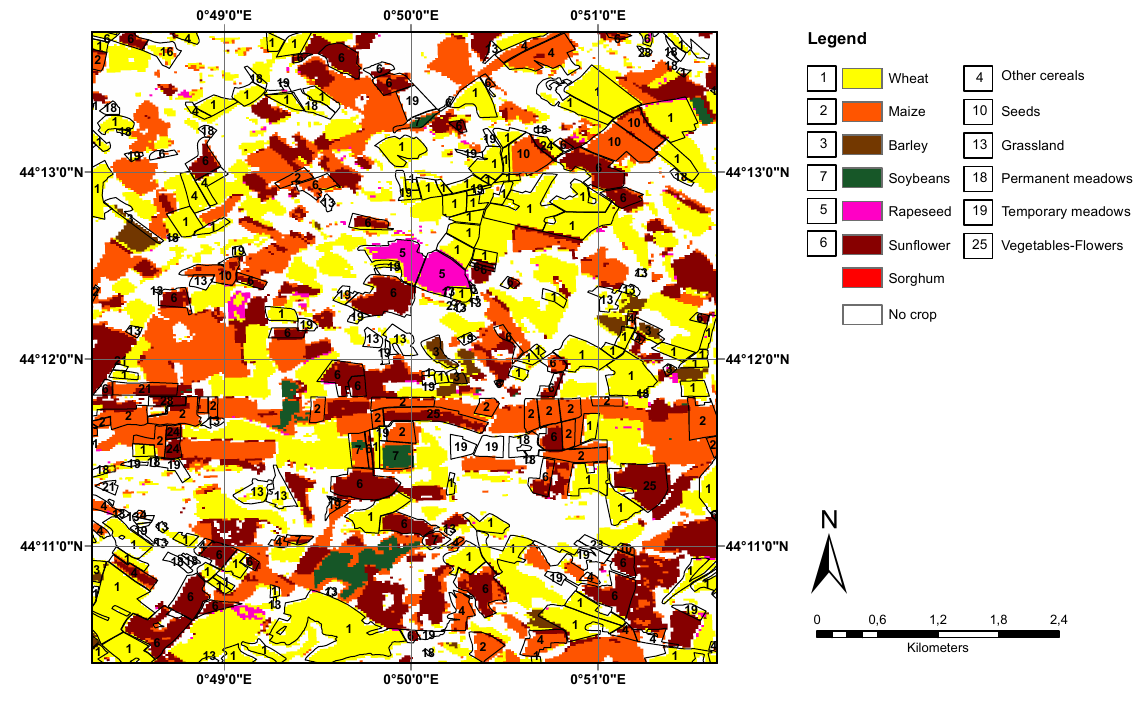
Figure 5. Comparison of the crop map type obtained using the RF classifier and field surveys with the RPG database in a region 40 km north to the field data collection site. Numbers indicate the crop type in the reference data and colors correspond to the output of the